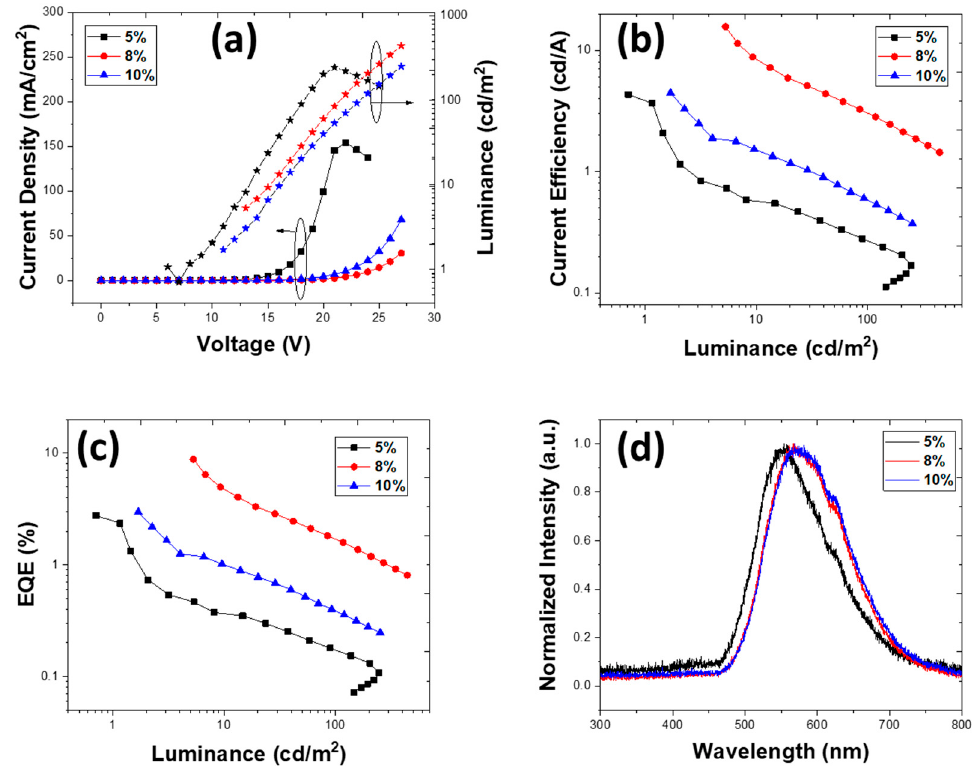
Figure 4. Device characteristics for structure ITO / PEDOT:PSS (40 nm) / PVK:OXD-7:TXO-TPA (x wt.%) (40 nm) / TmPyPb (40 nm) / LiF (1 nm) / Al (100 nm) deposited from chloroform. ( a ) Current density vs. voltage vs. luminance, ( b ) current efficiency vs. luminance, ( c ) EQE vs. luminance, and ( d ) electroluminescence spectra for 5, 8, and 10 wt.% (at 20 V).